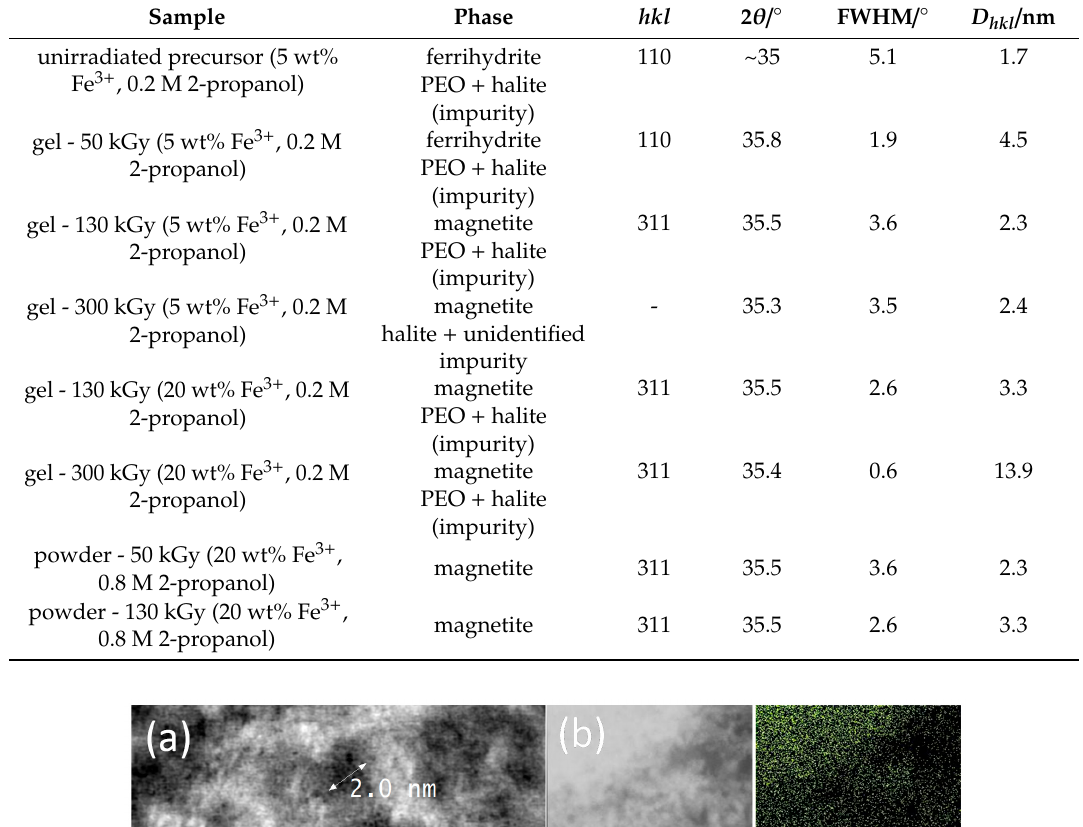
Table 1. The volume-averaged domain size ( D v ) of the dominant crystalline phase of selected samples. Sample